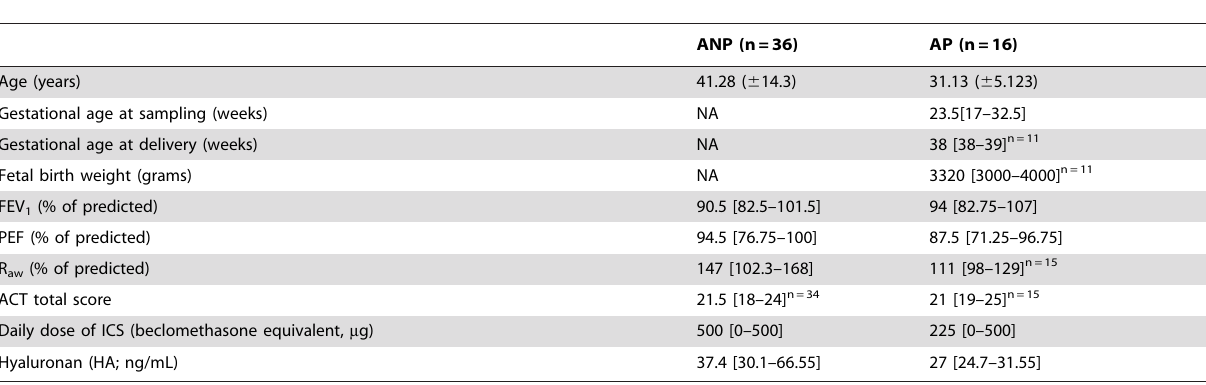
Table 1. Clinical data and circulating hyaluronan levels of the four study groups.